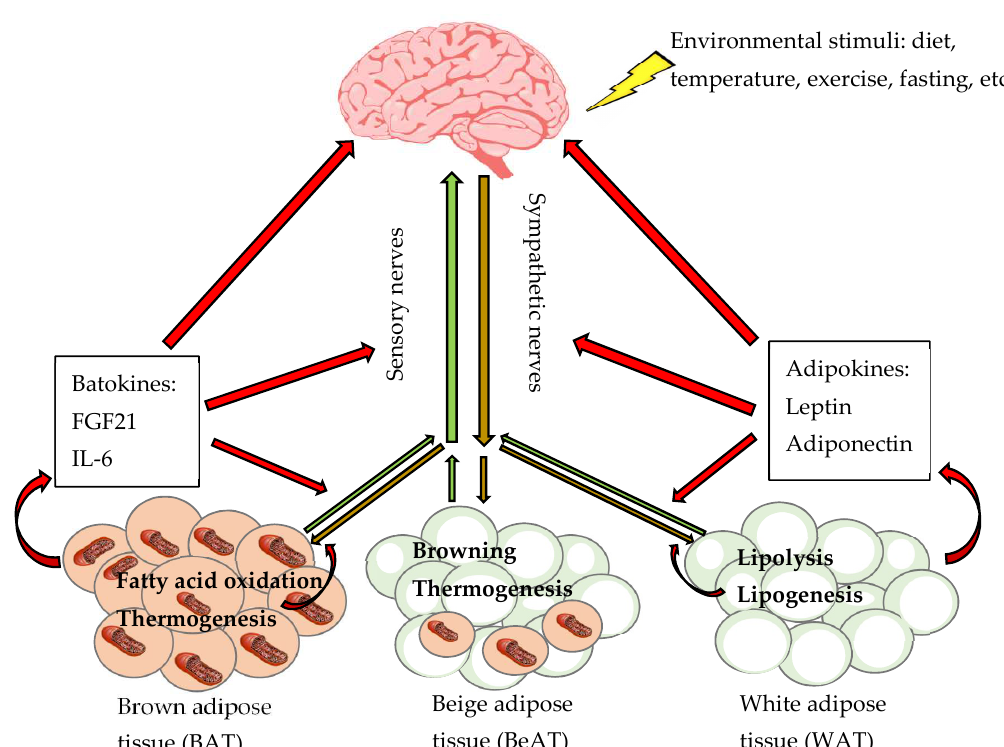
Figure 1. Neuroendocrine regulation of lipid metabolism at different types of adipose tissues. A two-way communication exists between the brain and white, brown and beige adipose tissues (WAT, BAT and BeAT, respectively) involving neural signals consisting of afferent sensory nerves (green arrows) and efferent sympathetic nerves (brown arrows), and endocrine signals (red arrows) consisting of WAT adipokines and BAT batokines. Environmental stimuli (i.e., diet, temperature, exercise, fasting) that change energy stores modulate sympathetic activity to regulate lipolysis, lipogenesis, and adipokine secretion at WAT; thermogenesis, fatty acid oxidation, and batokine secretion at BAT; and induction of BeAT and browning. A number of WAT adipokines (such as leptin and adiponectin) and BAT batokines (such as fibroblast growth factor 21 [FGF21] and interleukin 6 [IL-6]) interact with neural circuits to cooperatively regulate whole-body energy metabolism. Chronic dysregulation of energy balance due to energy intake exceeding energy expenditure results in excess lipid storage in adipose tissues, leading to obesity. Currently, 39.8% of adults and 18.5% of children in United States have a BMI over 30 and are classified as obese [7]. A number of environmental factors in Western society, including calorie-dense diet, sedentary lifestyle, and stress collectively contribute to an imbalance of energy homeostasis and development of obesity [8].